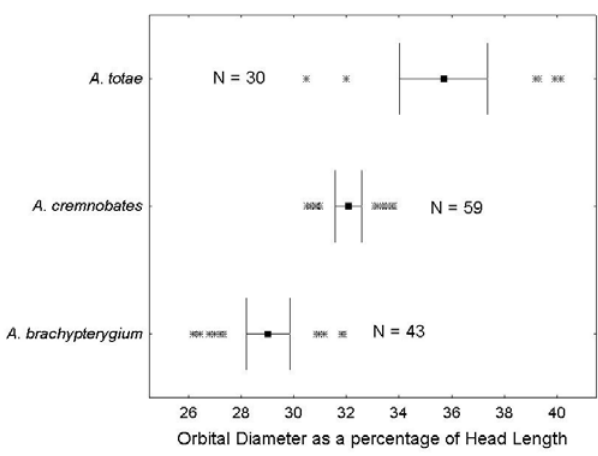
Fig. 5 . Anova box-whisker plots of the Orbital diameter as a percentage of Head Length in Astyanax totae , A. cremnobates and A. brachypterygium . Significant differences using one- way analysis of variance test were found among the species (F=46.83, P< 0.001). Mean represented by squares, and confi- dence intervals (95%) as lateral bars of box-whisker plots. Asterisks represent extreme